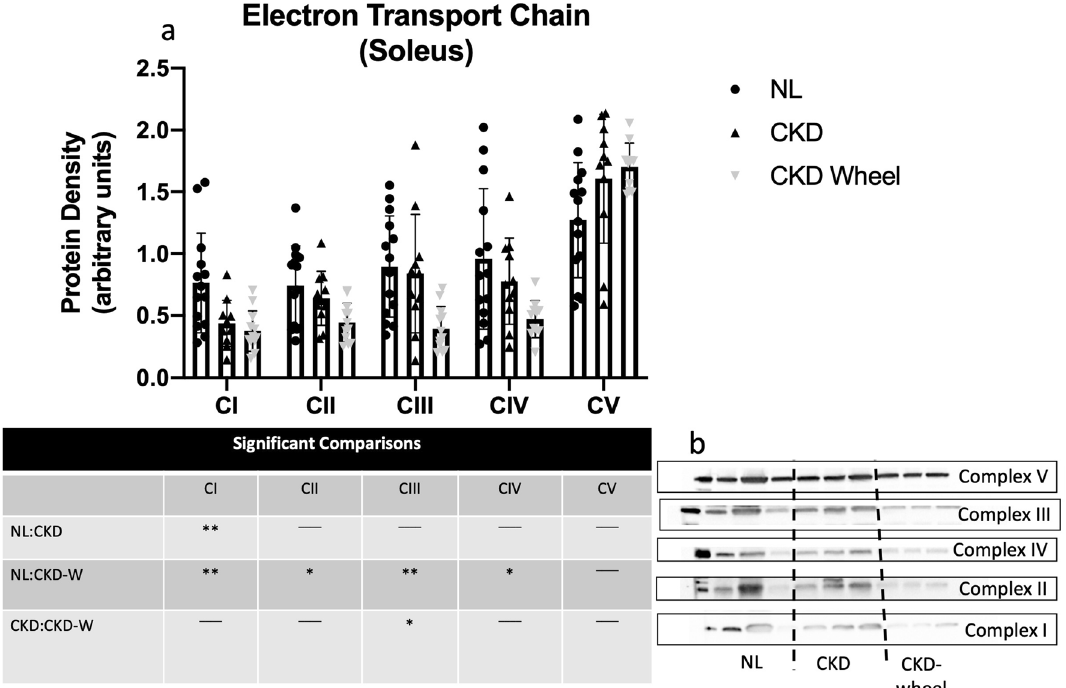
additional mitochondrial complex markers were different between NL and CKD. However, CKD-wheel rats demonstrated lower mitochondrial content for complexes I-IV subunits when compared to NL rats; only the complex III subunit demonstrated a CKD vs CKD-W difference. (b) Representative OXPHOS blots are provided with manipulated figures to unique exposures times per individual complex. Data are shown as mean ± SD (n = 9 rats each group). *P < 0.05, **P <